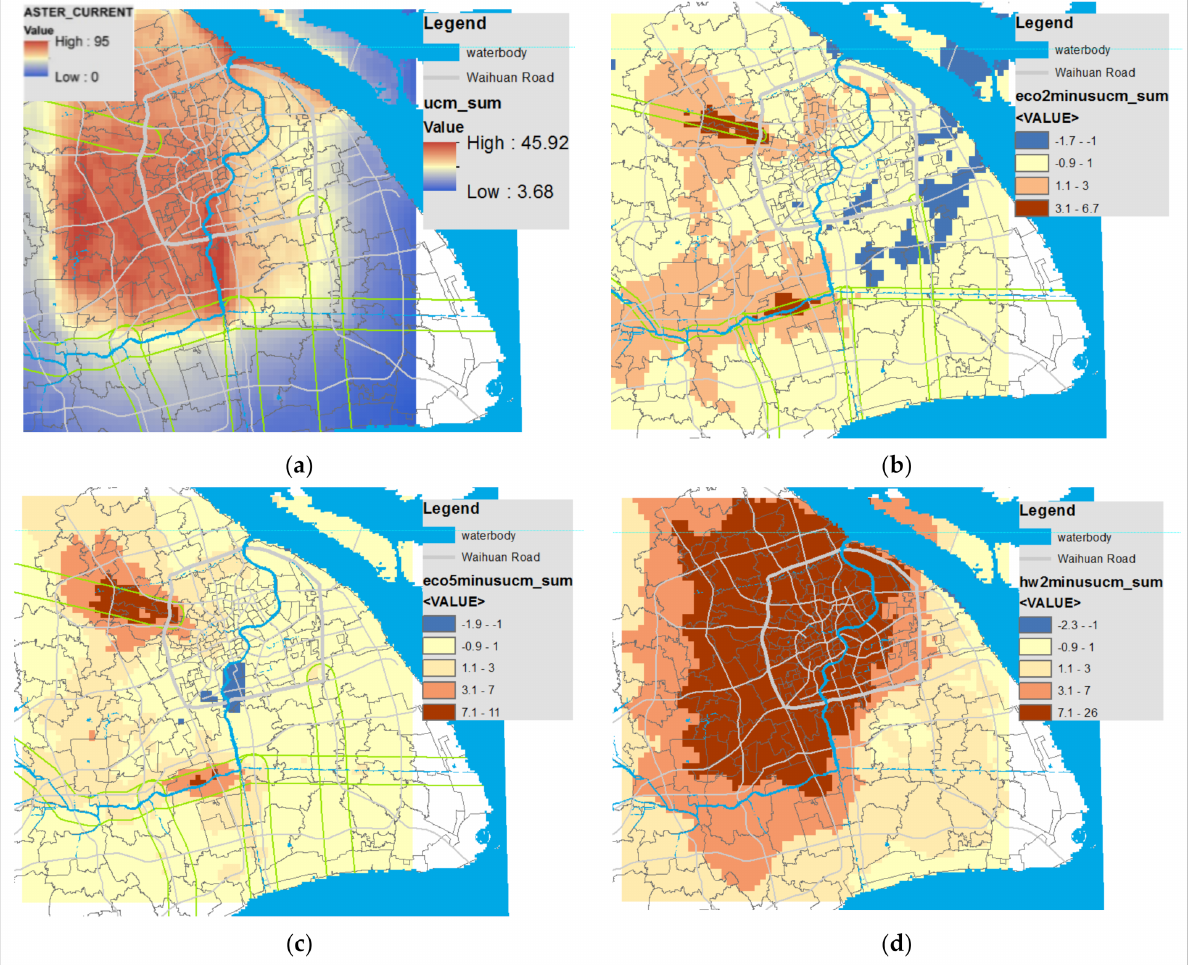
Figure 8. ( a ) Modeling ground-level PM2.5 concentrations ( µ g/m 3 ) in summer 2014; ( b ) modeling ground-level PM2.5 concentration differences ( µ g/m 3 ) in the ECO02 scenario and base scenario; ( c ) modeling ground-level PM2.5 concentration differences ( µ g/m 3 ) in the ECO05 scenario and base scenario; ( d ) modeling ground-level PM2.5 concentration differences ( µ g/m 3 ) in the HW02 scenario and base